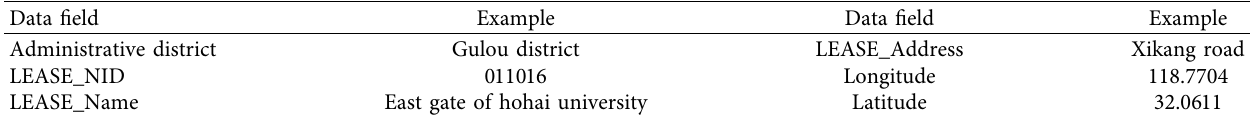
Table 2: Data fields and descriptions of bicycle-sharing rental stations.